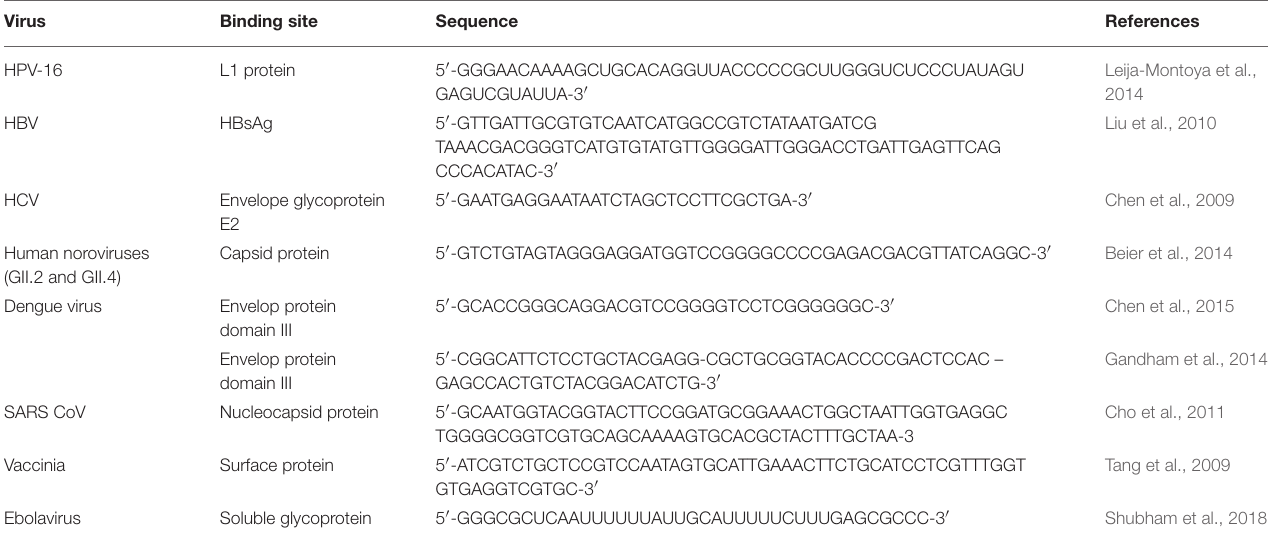
TABLE 4 | Summary of aptamers that have not been used in virus detection or antiviral therapy.